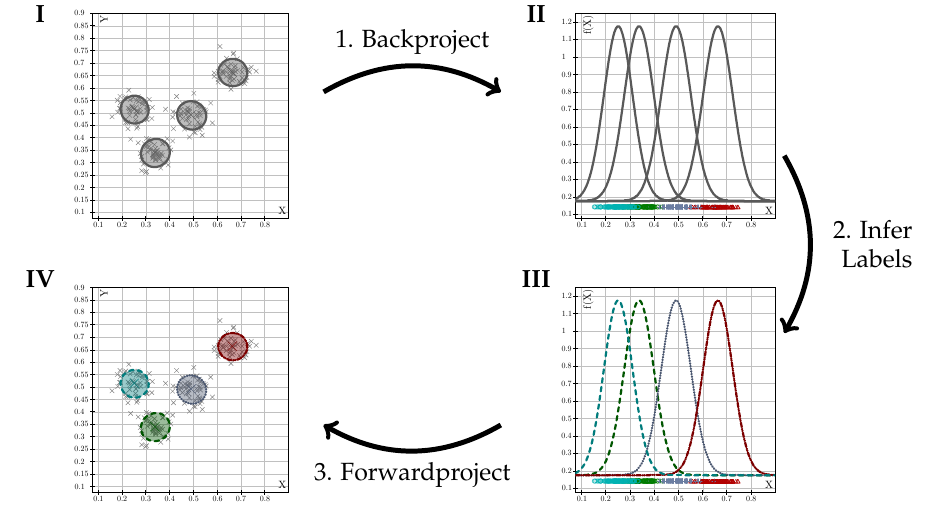
Figure 1. Schematic visualization of classifier adaptation, given a working 1D classifier: Observations in 2D are modeled by a density model ( I , top left), which is then backprojected (1) to the original input space ( II , top right), where labels are inferred from the 1D training data. (2) This leads to an adapted classifier in the original input space ( III , bottom right) . The classifier is then forwardprojected (3) to the 2D input space ( IV ). Crosses are data points, ellipses are height-lines of 2D components. The left column of graphs represents the 2D input space, the right column the original 1D input